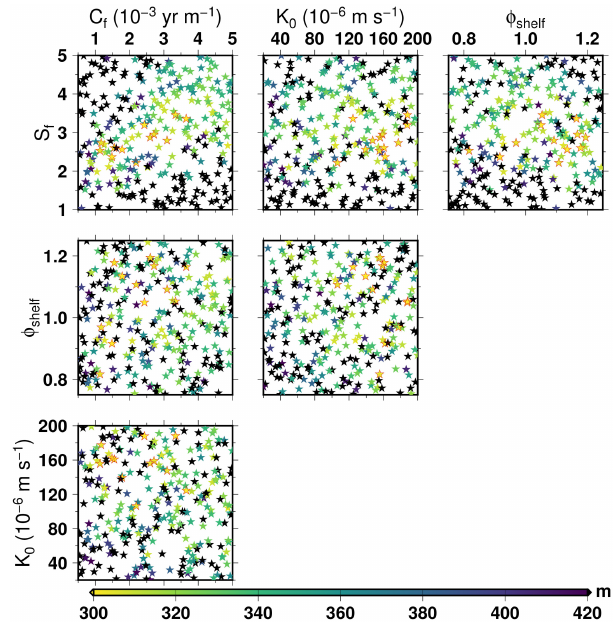
Figure 10. Same as Fig. 9 but with the Tsai et al. (2015) formulation of the flux at the grounding line